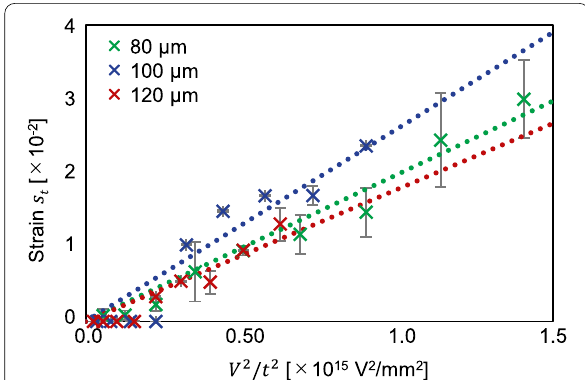
Fig. 2 Results of experimental and theoretical analyses of DEAs with a uniaxial